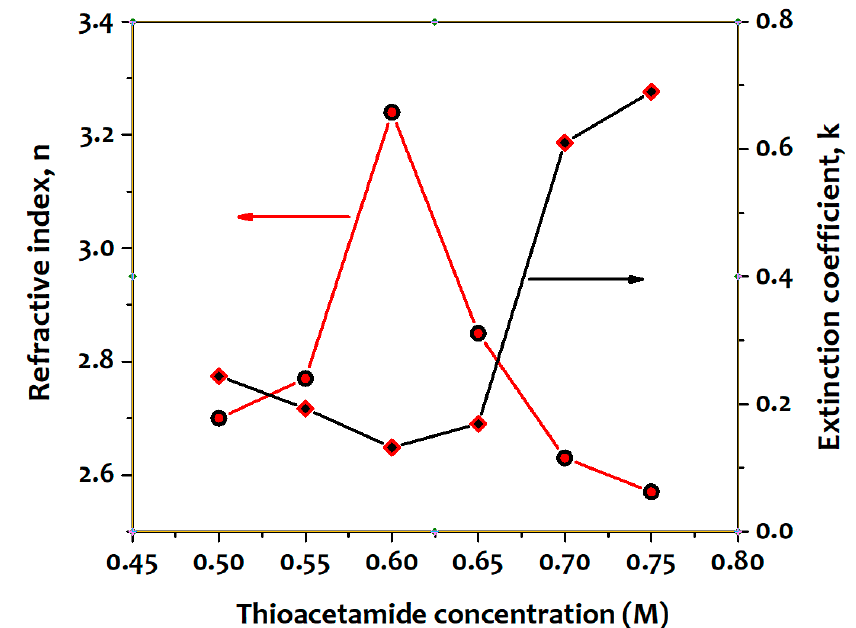
Figure 6. Tauc’s plots of the films deposited at different TA concentrations. 183